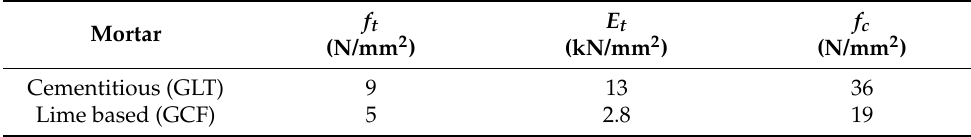
Table 1. Mechanical properties of the mortar matrices.